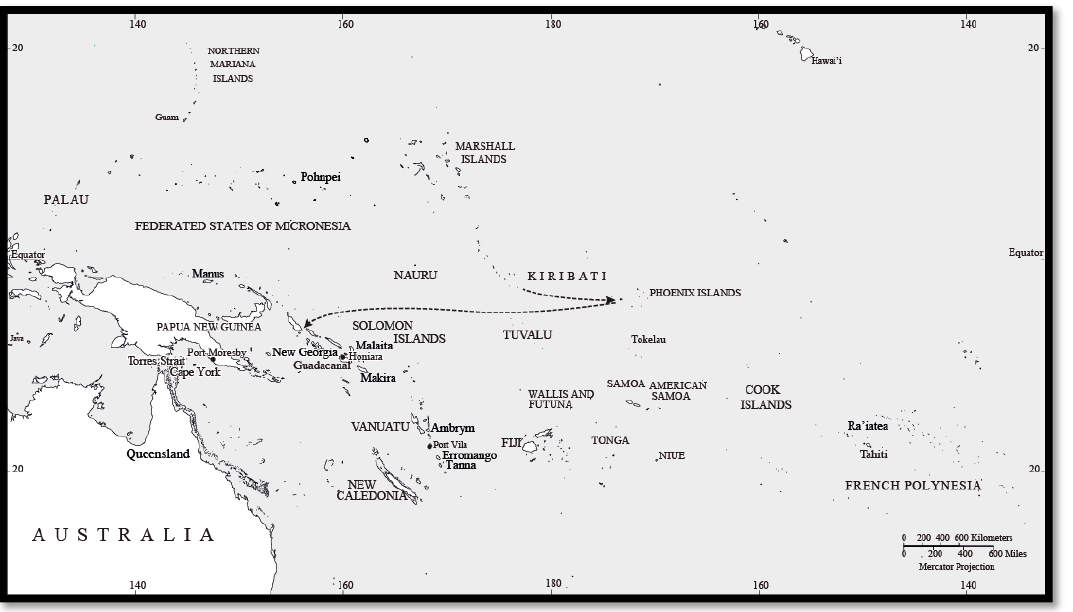
Figure 2. Map showing the Gilbertese resettlement routes from Gilbert Islands to Phoenix Islands, and Phoenix Islands to Solomon Islands.